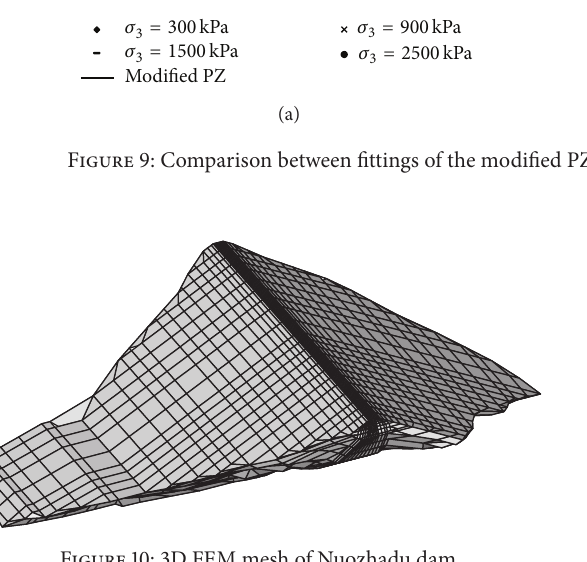
Figure 10: 3D FEM mesh of Nuozhadu